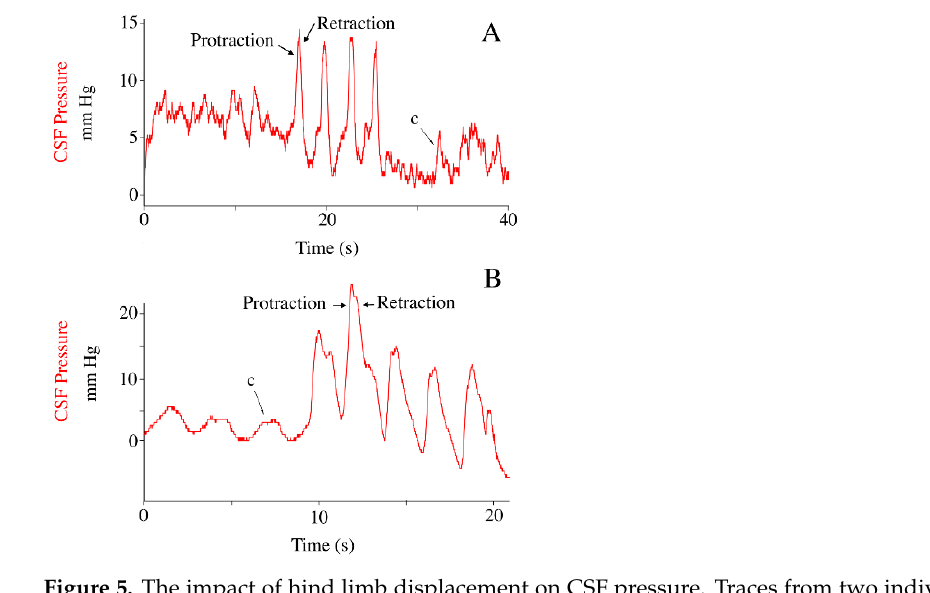
Figure 5. The impact of hind limb displacement on CSF pressure. Traces from two individuals of Alligator mississippiensis ( A , B ) showing the similar patterns of CSF pulsations (red) recorded during movement of the pes. Protraction of the pes caused an increase in CSF pressure, which decreased during retraction of the pes. c—individual cardiac-related pulsation.